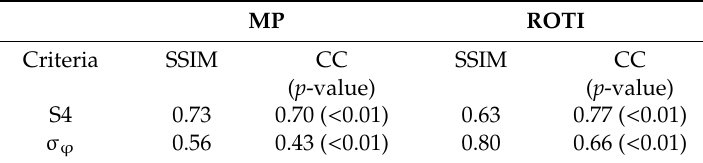
Table 3. SSIM and CC between the maps shown in Figure